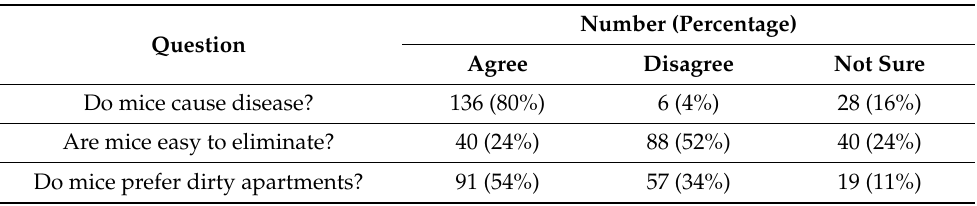
Table 1. Resident responses to questions regarding perceptions about mice regarding disease, management and conducive conditions (n =